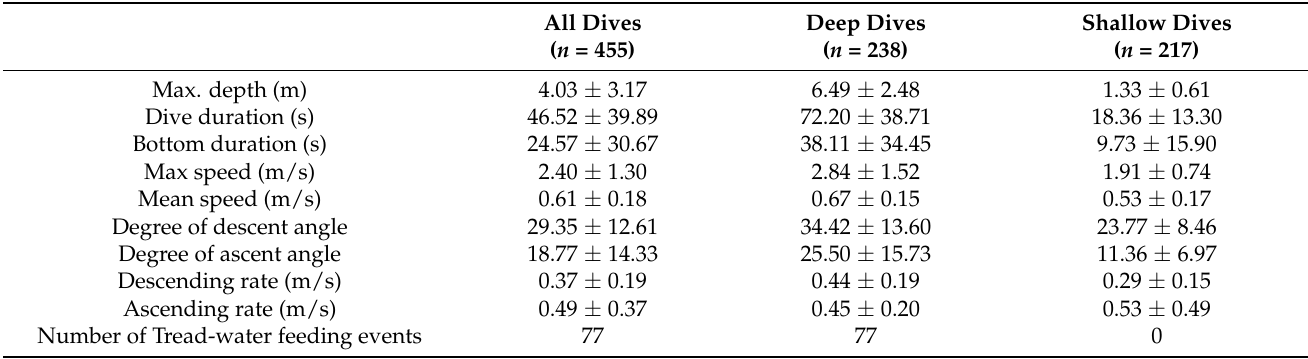
Table 2. Summary of descriptive statistics (mean ± standard deviation) for dive parameters of the Bryde’s whale on 2 and 4 July 2021.